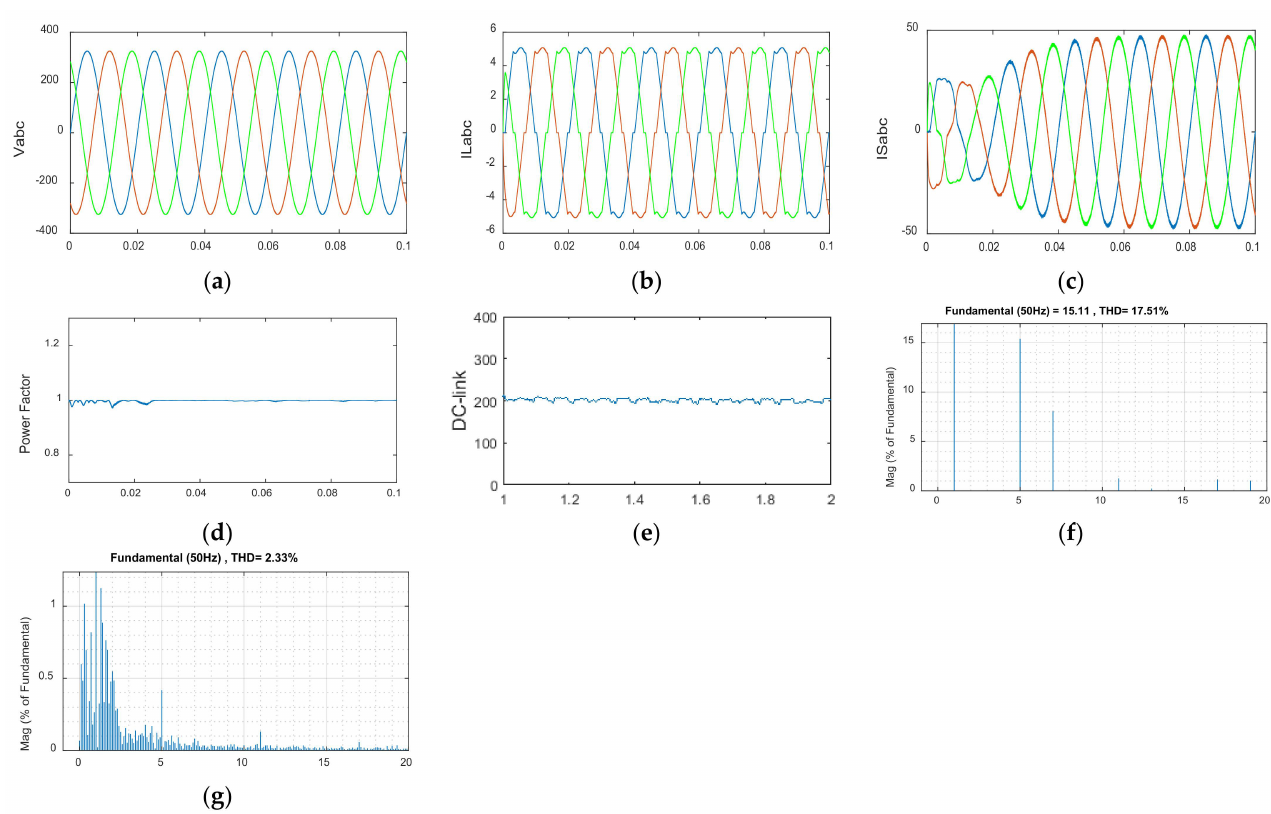
Figure 8. The simulation results of the proposed algorithm in ‘Section 3.1’: ( a ) Balanced and sinusoidal 3-phase voltage source; ( b ) 3-phase source current before mitigation; ( c ) 3-phase source current after mitigation; ( d ) power factor; ( e ) DC-link voltage; ( f ) THD for load current; ( g ) THD for line